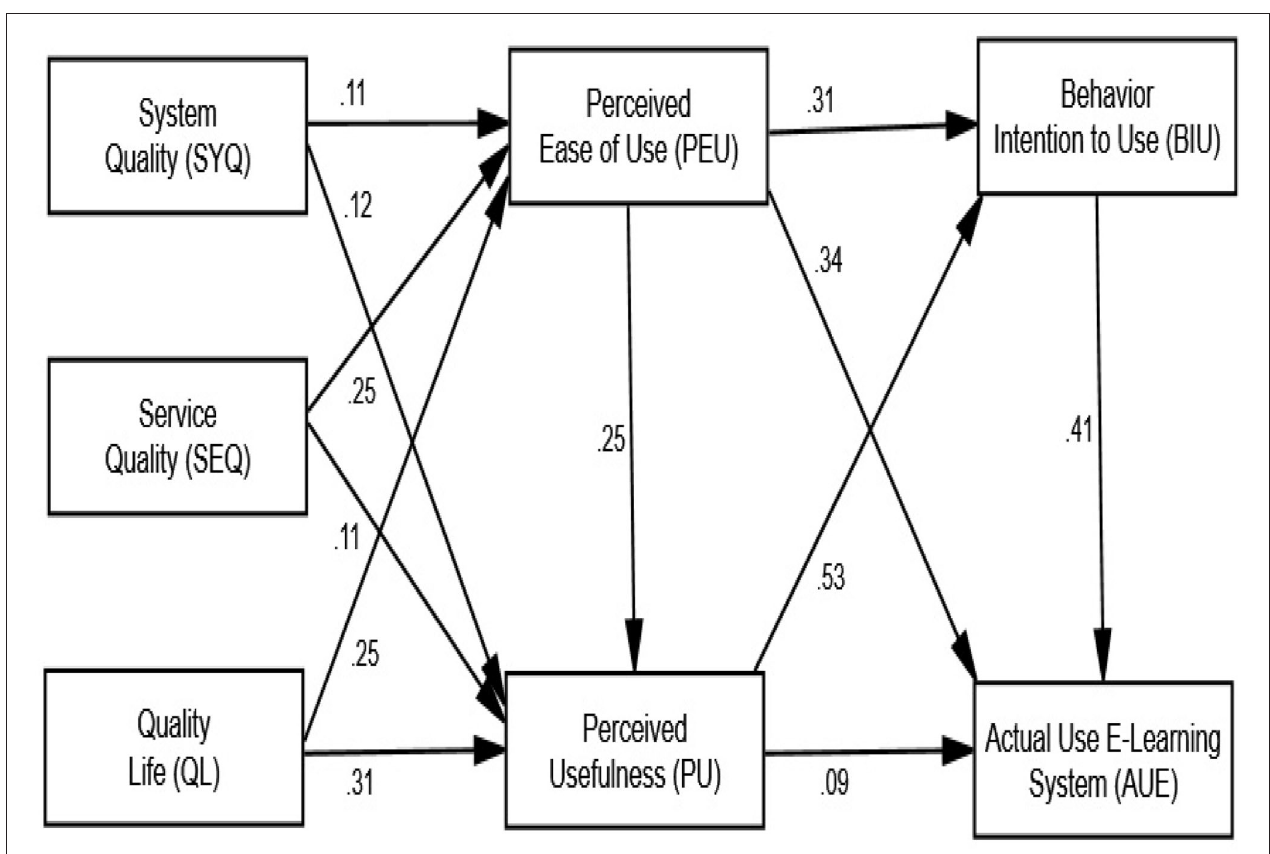
FIGURE 3 | Structural model ( p